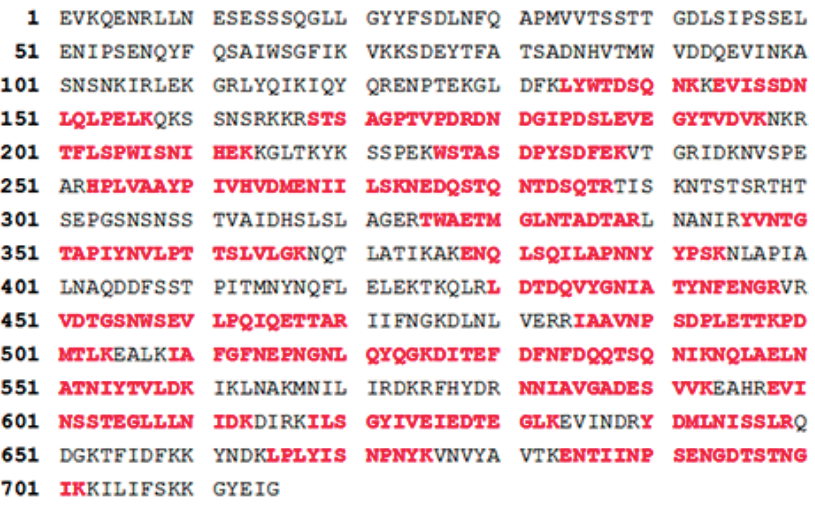
Figure 4. MS-based identification of anthrax protective antigen. The peptides were identified to match the PA sequence and are given in bold red.